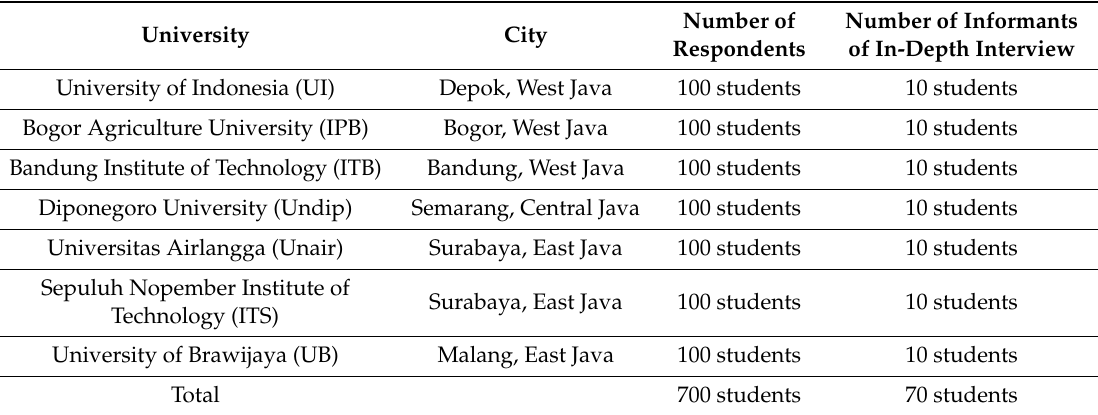
Table 1. Respondents and Informants of the